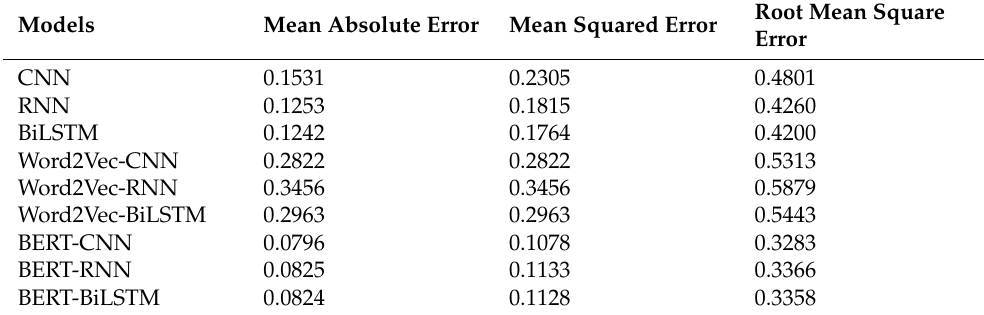
Table 9. Error evaluation.